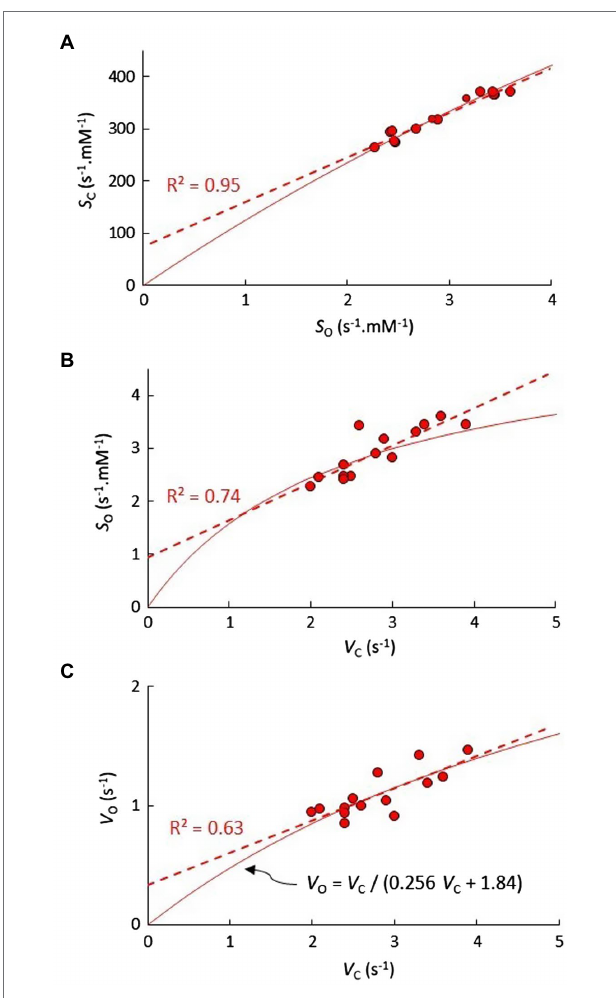
FIGURE 3 | The predicted trend (solid line) in (A) S C vs. S O for genus C 3 Limonium , determined using the set of parametric equations describing the trends in S C vs. V C ( Figure 1B ) and (B) S O vs. V C . In (B) , the solid trend line for S O vs. V C is determined by substituting (C) the hyperbolic equation obtained from the nonlinear least squares fit of the V O vs. V C, data for V O in the equation for the predicted S O vs. V O curve ( Figure 1D